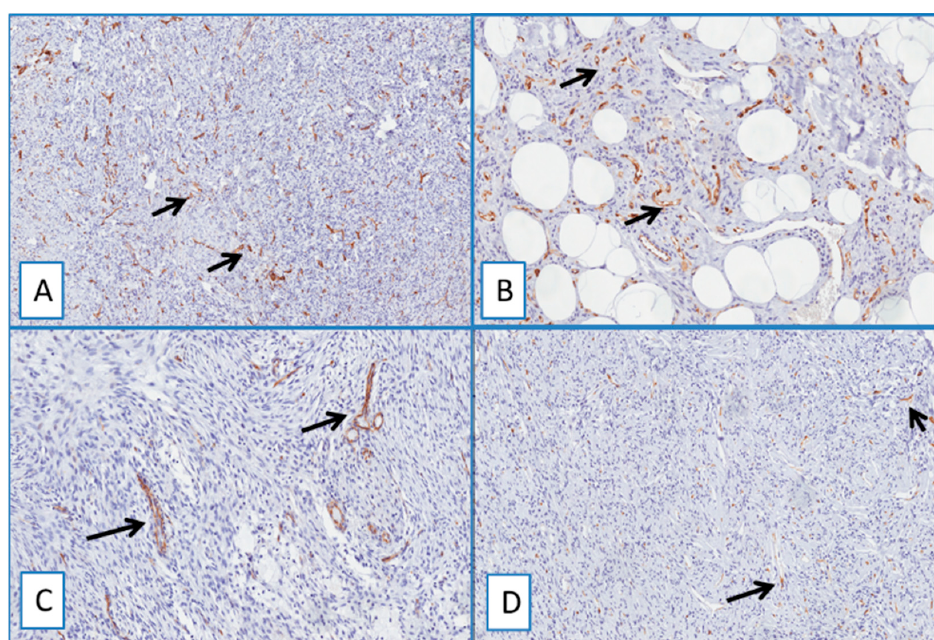
Figure 5. Immunohistochemical analyses showed no detectable staining for WT1 in dermatofi ‐ broma ( A ), spindle cell lipoma ( B ), nodular fasciitis ( C ), and solitary fibrous tumor ( D ). Cytoplasmic staining of blood vessels served as a positive internal control (arrows) (immunoperoxidase; original magnifications 50× ( A , D ) and 150× ( B , C )).